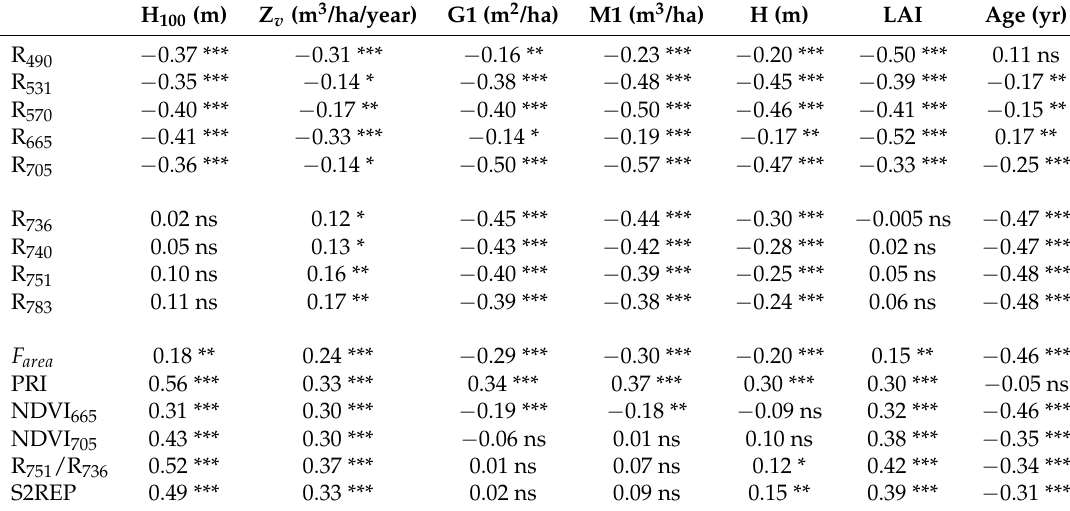
Table 3. Spearman’s rank-order correlation coefficients among forest inventory variables (site index (H 100 ), stem volume increment (Z v ), basal area for dominant layer (G1), stemwood volume for dominant layer (M1), height of the tree with average basal area also known as Lorey’s height (H), allometric estimate of leaf area index (LAI) and stand age), single band reflectance factors in visible and near infrared spectral regions and spectral transformations (in-filling of the O 2 -A Fraunhofer line around 760 nm ( F area ), Photochemical Reflectance Index (PRI), Normalized Difference Vegetation Indices (NDVIs), new simple ratio at 736 nm and 751 nm (R 751 /R 736 ), and red-edge inflection point estimated by linear four-point interpolation approach (S2REP)). Asterisks denote statistical significance. H 100 (m) Z v (m 3 /ha/year) G1 (m 2 /ha) M1 (m 3 /ha) LAI Age